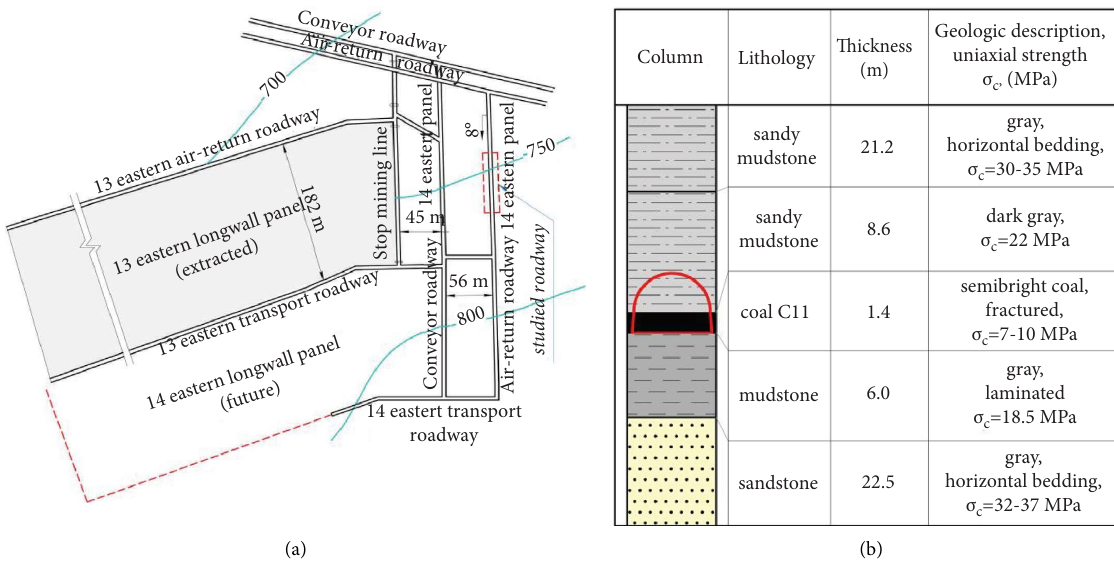
Figure 1: Te studied area and geological conditions: (a) the locations of the studied roadway; (b) strata